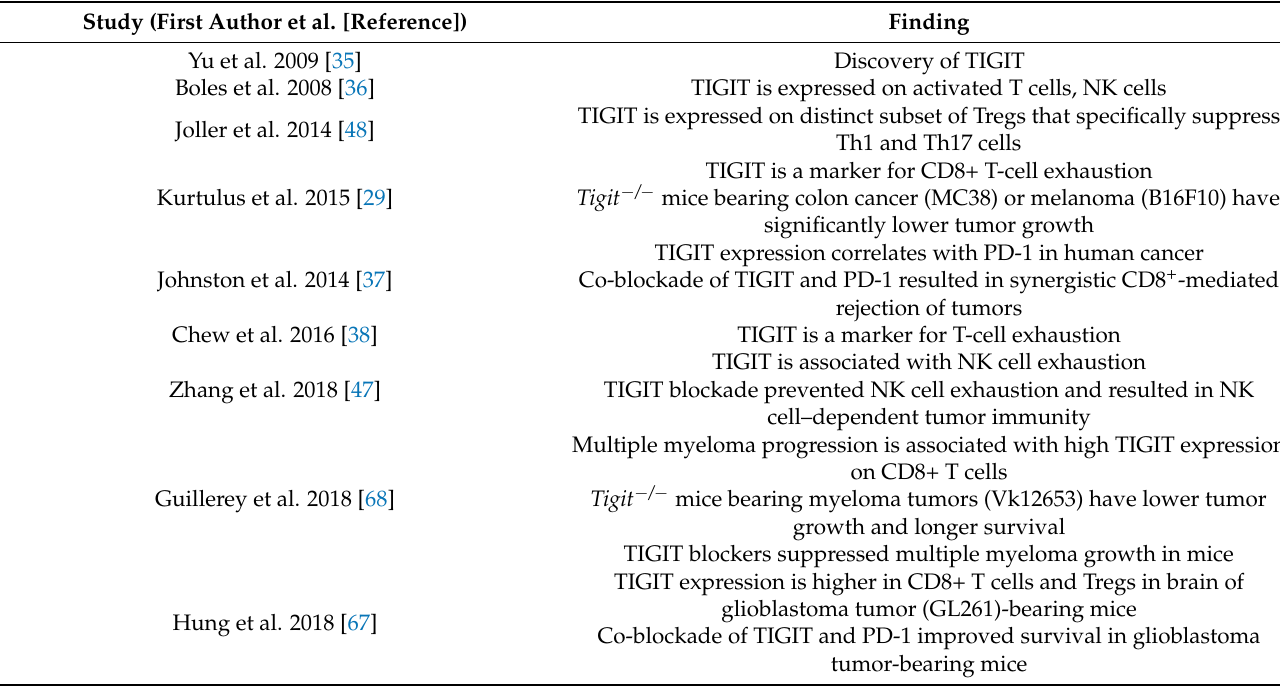
Table 2. Summary of key preclinical